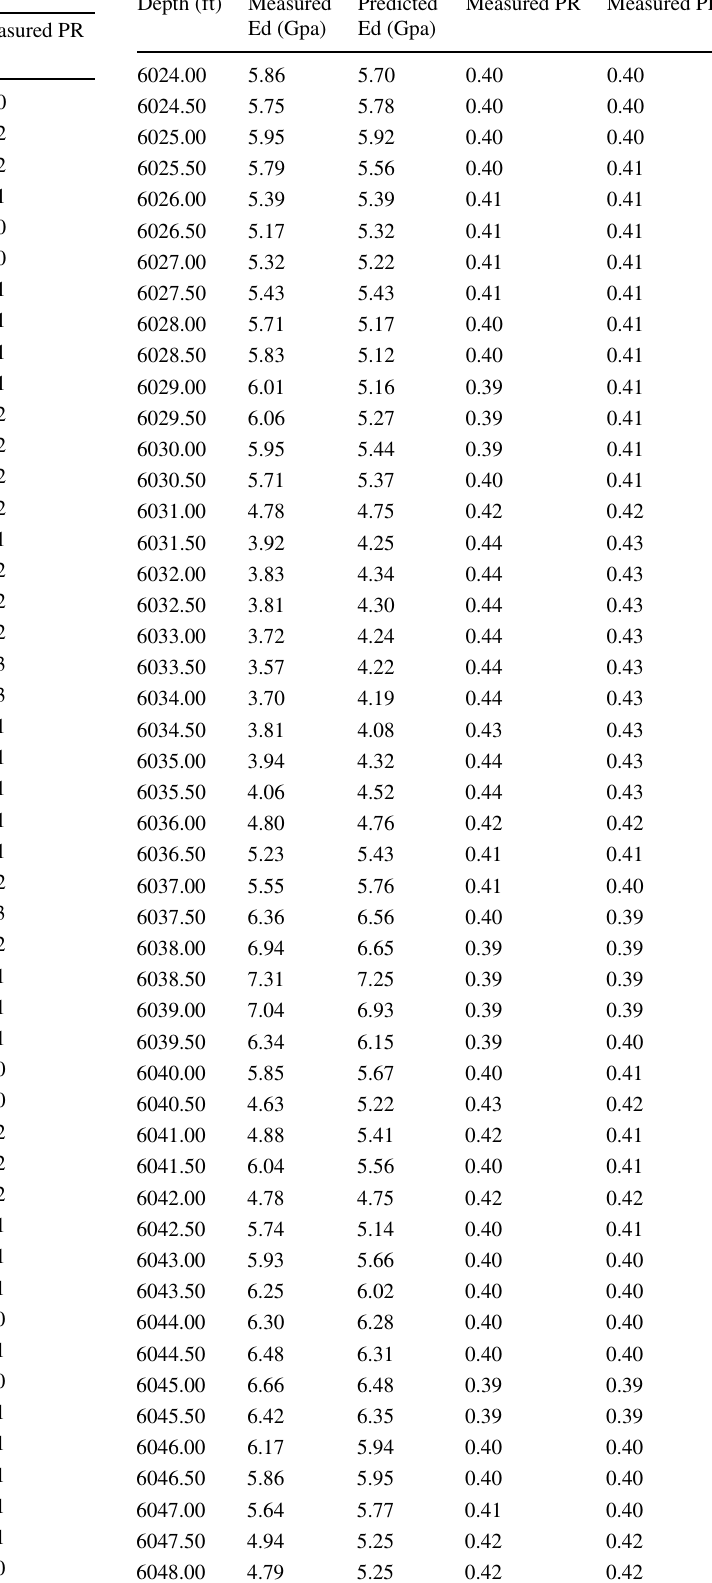
Table 6 Sensitivity analysis data (dynamic Young’s modulus and Poisson’s